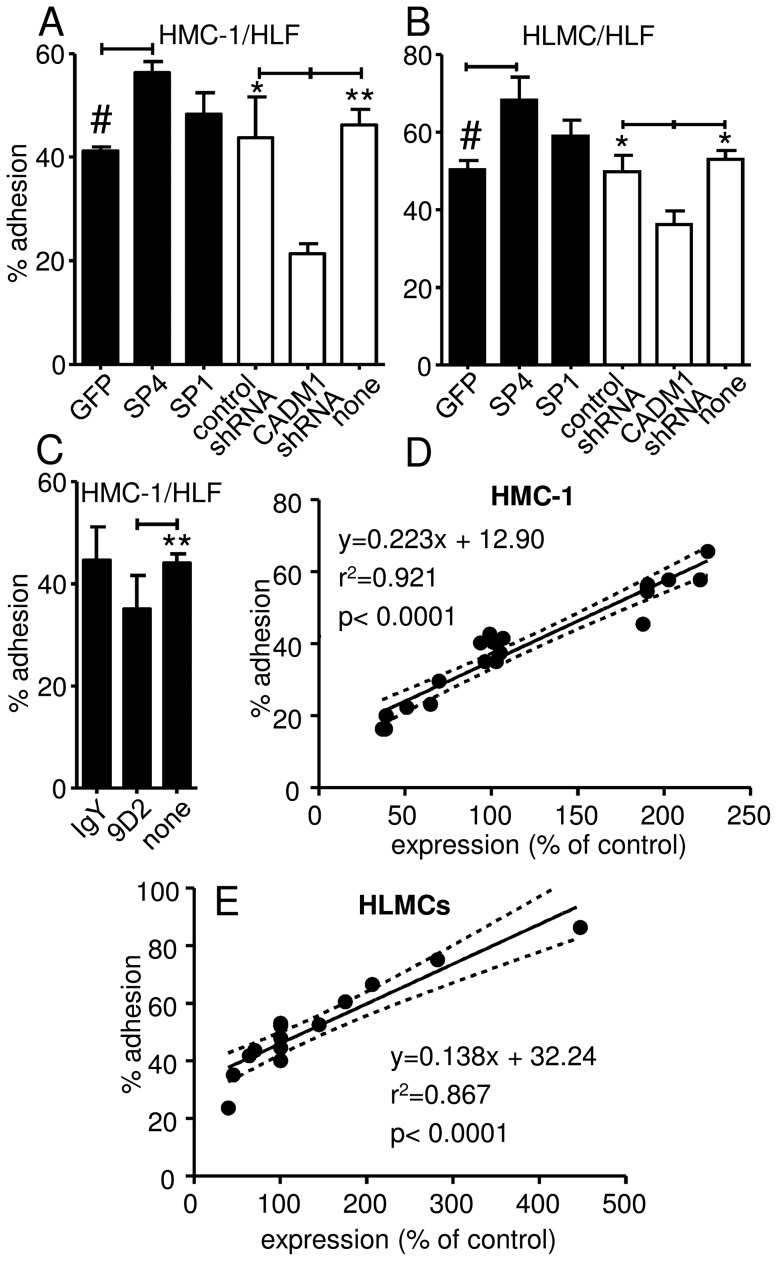
CADM1 is responsible for mast cell adhesion to primary human lung fibroblasts.HMC-1 cells and HLMCs were transduced with SP4, SP1, CADM1 shRNA, GFP or luciferase control shRNA using adenoviral delivery, followed by the study of adhesion to HLFs. A) Downregulation of CADM1 reduced HMC-1 cell adhesion to HLFs (n = 3–6 for different groups), while overexpression of SP4 increased it. *p<0.05, **p<0.01 compared to CADM1 shRNA. #p<0.05 compared to SP4. B) Downregulation of CADM1 reduced adhesion of HLMCs (n = 4) to HLFs (n = 5), while SP4 overexpression increased adhesion. *p<0.05 compared to CADM1 shRNA. #p<0.05 compared to SP4. C) HMC-1 cells pre-incubated with anti-CADM1 9D2 Ab adhered less to HLFs compared to controls (n = 3). **p<0.01 compared to 9D2. D) and E) Scatter plots with regression model parameters for the CADM1 surface expression levels and the degree of adhesion to HLFs by HMC-1 cells (D) and HLMCs (E), which include the data for transduced cells from Fig. 3 including SP4, luciferase control shRNA and CADM1 shRNA transduction groups (20 points in D and 14 points in E) and their expression data published previously in Fig 2b of reference 26 for HMC-1 cells and Fig. 1 in this paper for HLMCs.